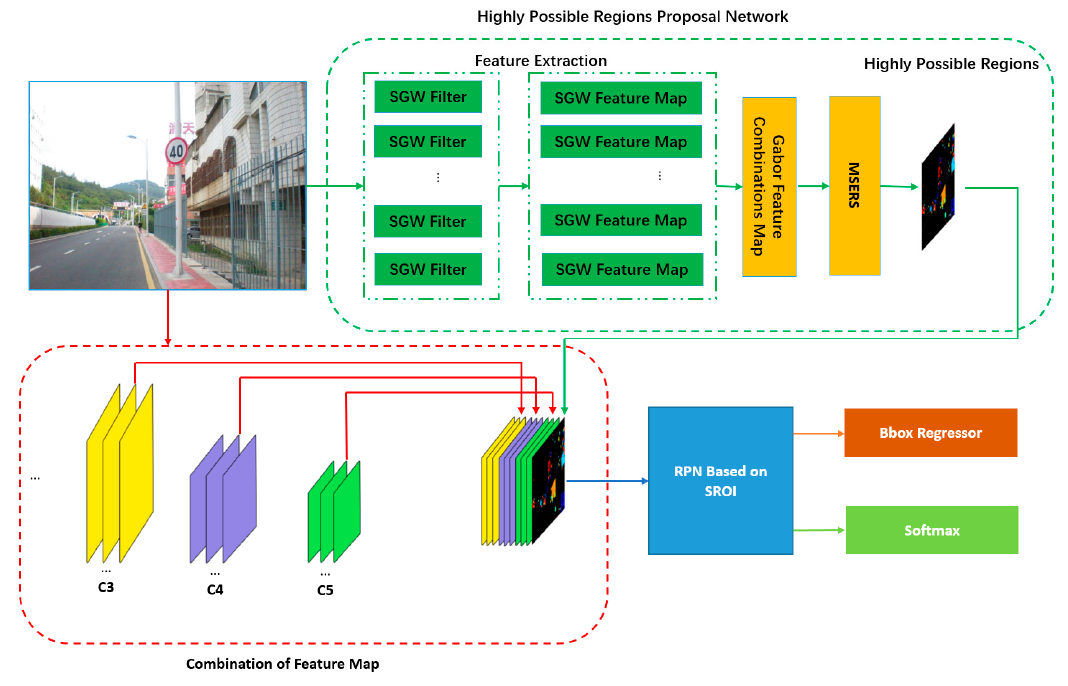
Figure 2. The processing flow of our method.